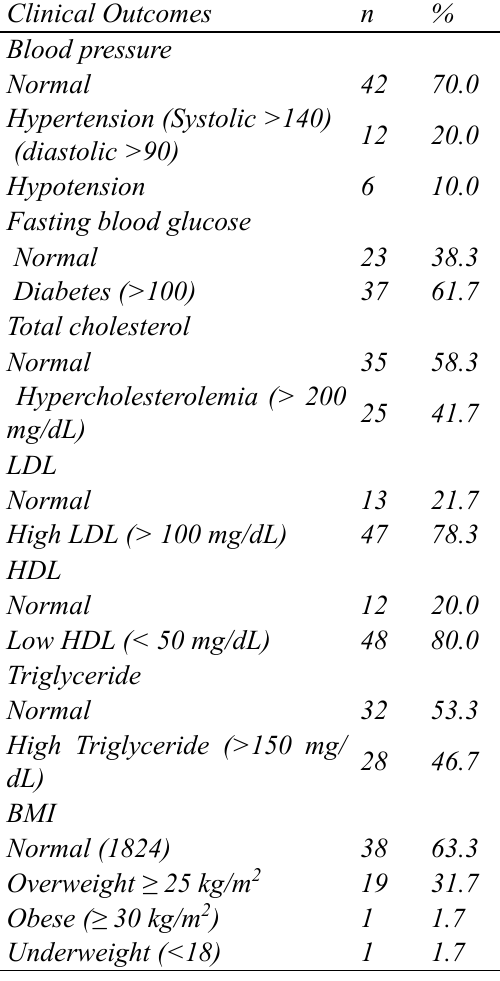
Table 4. Frequency and percentage of clinical